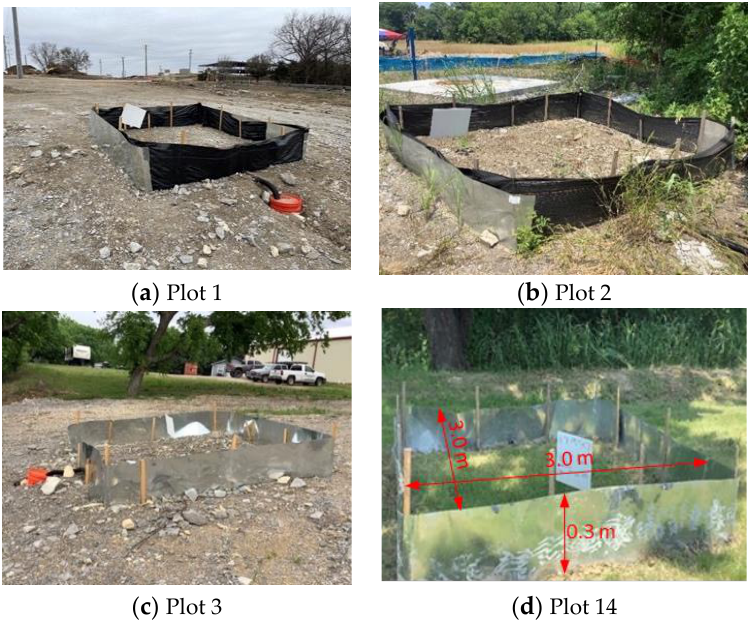
Figure 9. Erosion plots installed at the Wilson Creek bridge construction site (all plots were 3 m × 3 m × 0.3 m). 3 m × 0.3